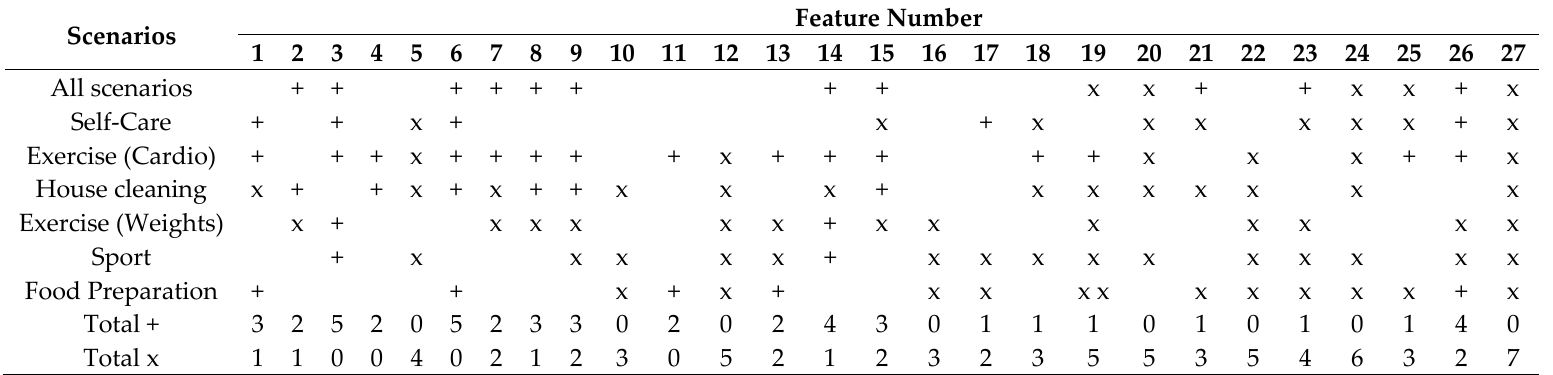
Table 5. Relevant and not relevant features selected by the two feature selection